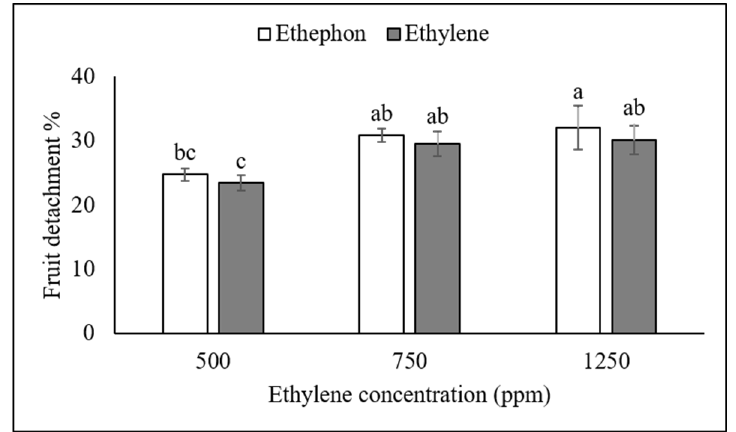
Figure 4. Ethephon and ethylene treatment at different concentrations induced fruit detachment in oil palm bunches. The data were presented as means of the replicates ( n = 5) and vertical bars indicate standard deviation. Means that do not share a letter are significantly different at p < 0.05 according to Tukey’s range test.